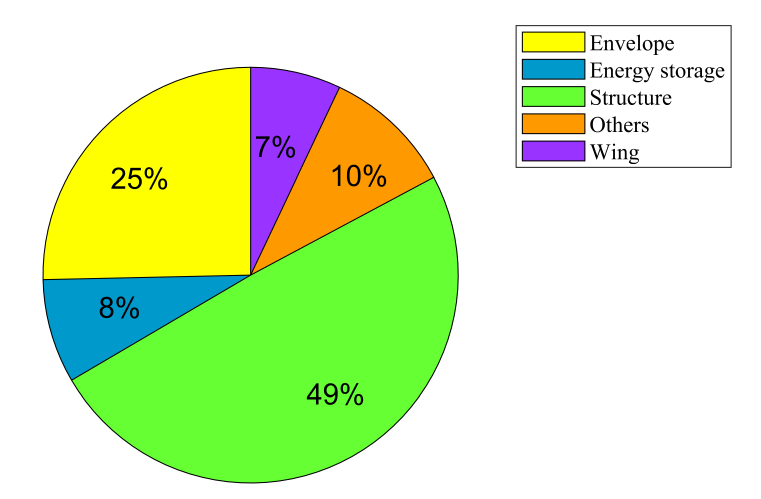
Figure 24. Conventional airship, I day = 354.